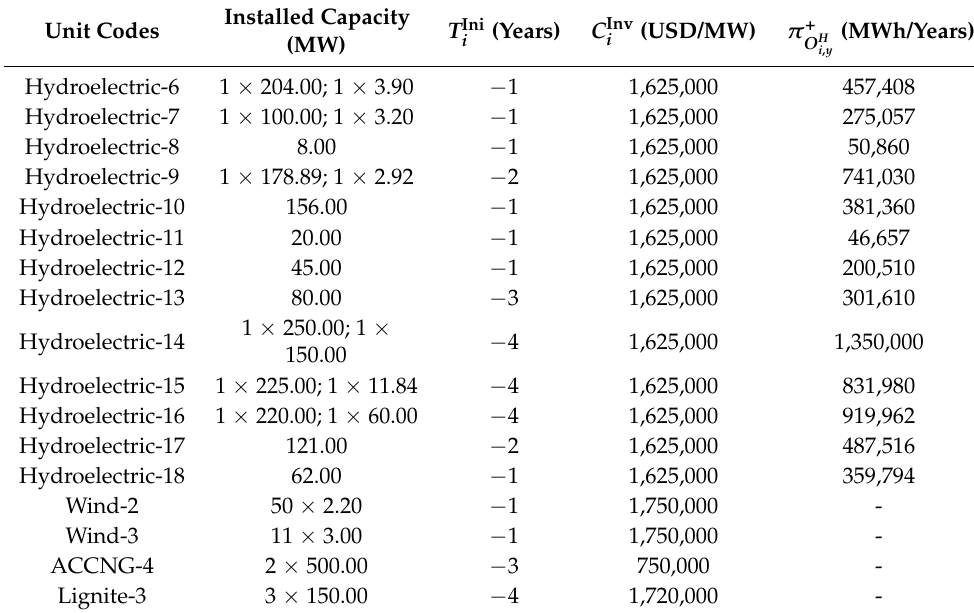
Table 3. Generation units’ data in the commissioning